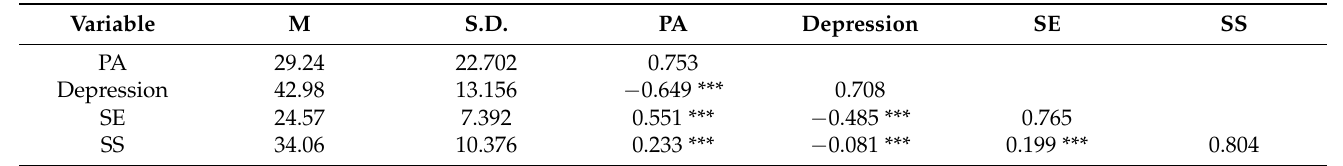
Table 4. Descriptive statistics and correlation of variables.